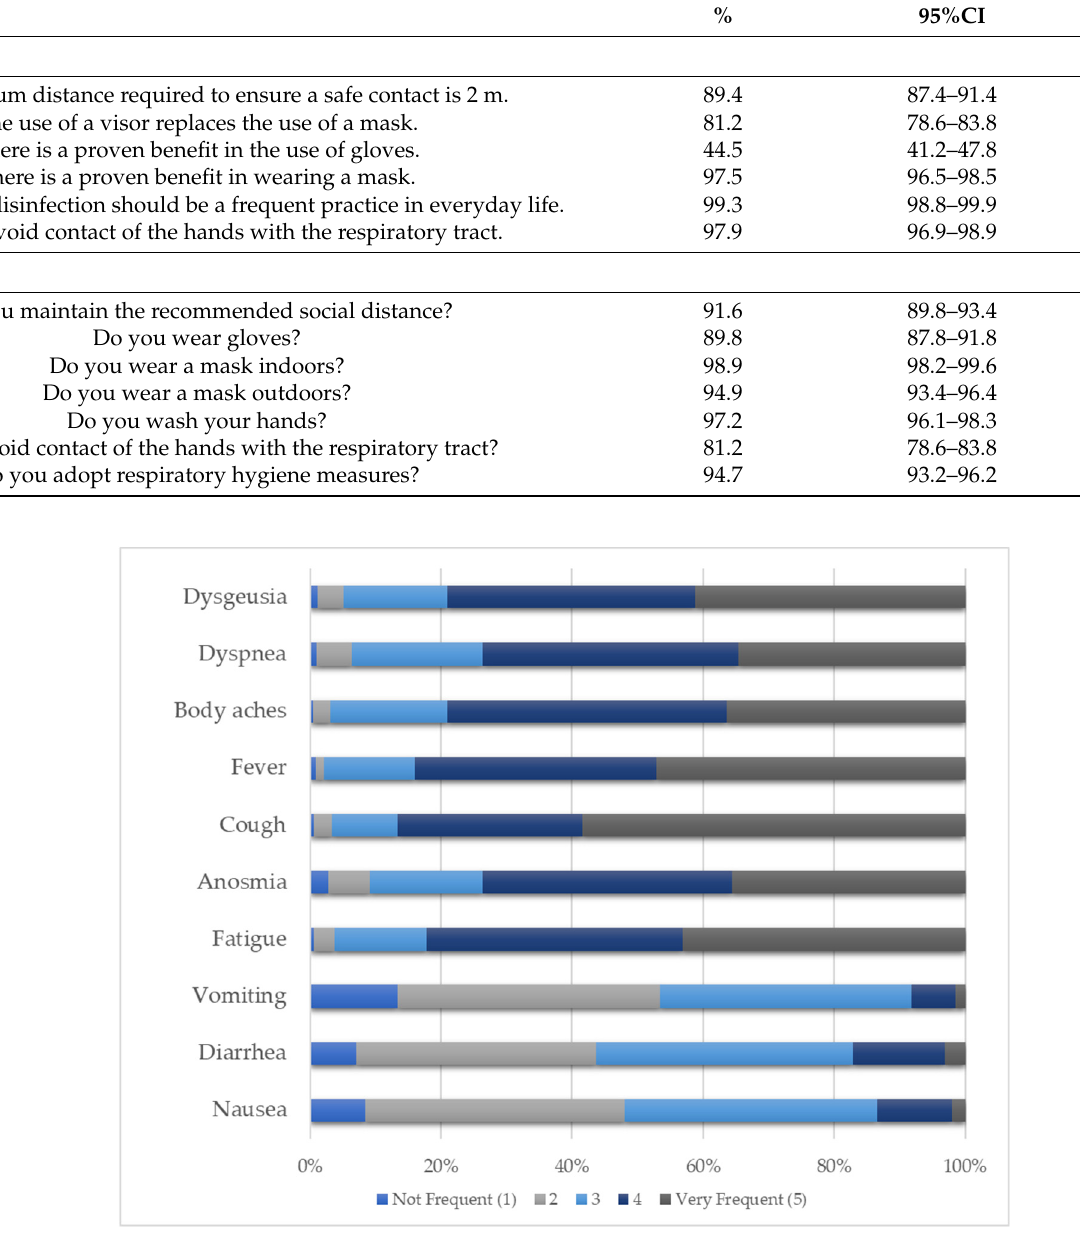
Figure 1. Participants’ knowledge about the symptoms related to COVID-19.